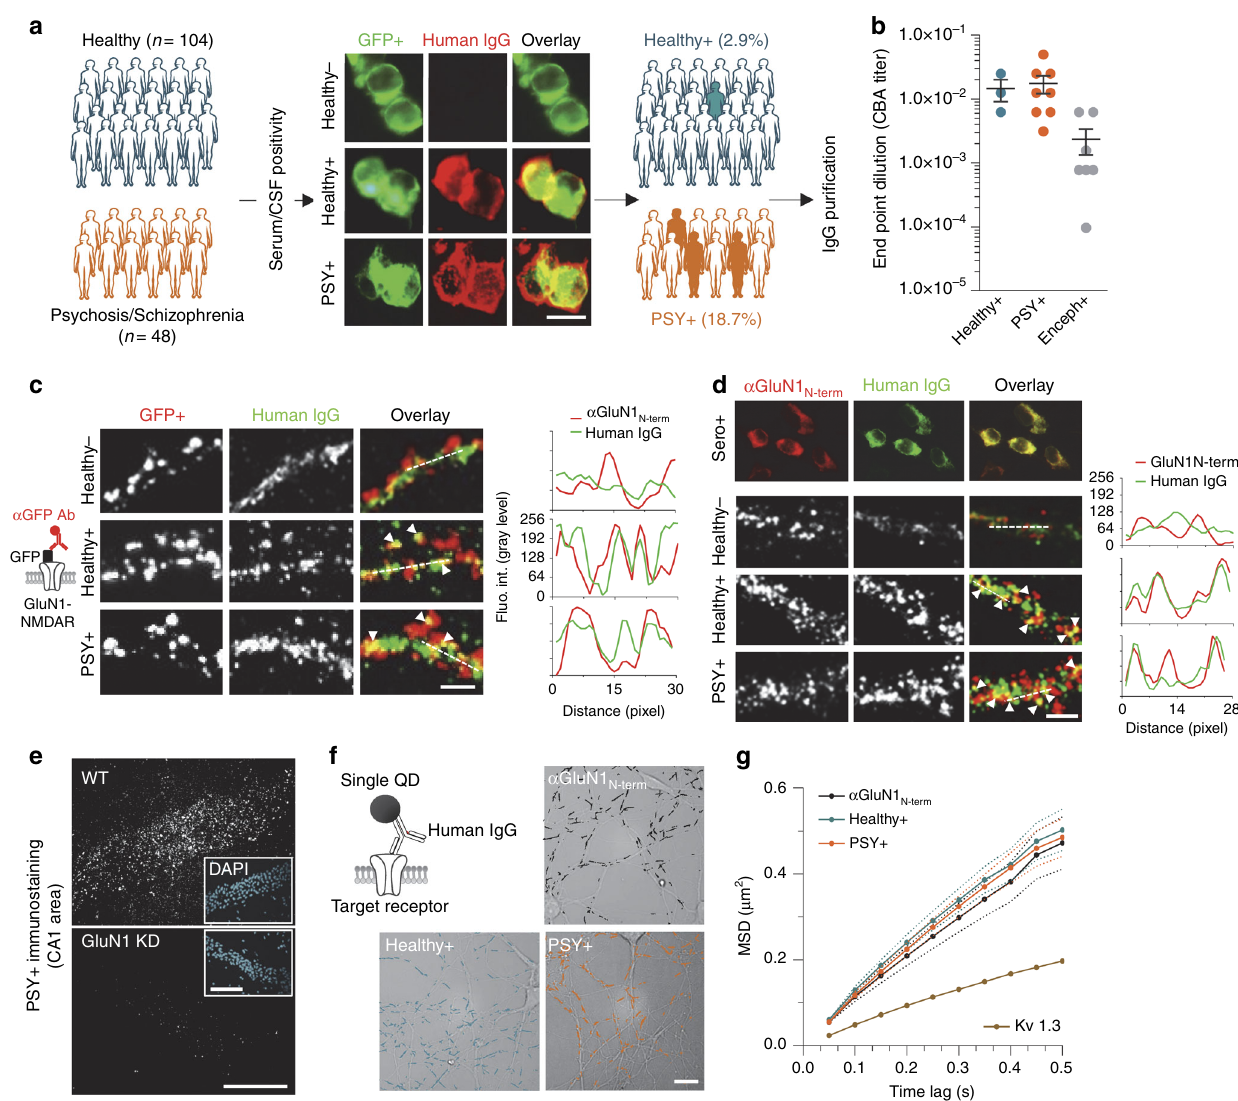
Fig. 1 Multi-approach identi fi cation of NMDAR-Ab IgG in the serum of schizophrenia patients and healthy subjects. a Immunostaining of HEK293 cells expressing GluN1-GFP and GluN2B subunits labeled with the sera of healthy subjects or schizophrenic patients (1/10, 3 h incubation). Note the overlap between serum reactivity (red) and GFP-positive HEK cells (green) for seropositive samples. Scale bar, 10 µ m. b Mean ± SEM of NMDAR-Ab titers estimated by end-point dilutions for Healthy + ( n = 3 samples), PSY + ( n = 8) and Enceph + ( n = 7) serum samples. Each data point represents the value calculated for a subject or a patient. c Surface co-immunostaining for GluN1-SEP containing NMDAR (red) and human puri fi ed IgG ’ s target (green) in live hippocampal neurons. Both Healthy + and PSY + IgG detect a target that colocalizes with surface GluN1-SEP clusters (white arrowheads). Scale bar, 2 µ m. Right panel: corresponding linescans plotting GFP + and human IgG fl uorescence intensities over distance (pixel). d Upper panel: surface co- immunostaining of HEK293 cells with a commercial anti-GluN1 antibody targeting the extracellular part of the GluN1 subunit and seropositive samples. Lower panel: representative dendritic areas of cultured hippocampal neurons (12 div) co-labeled with puri fi ed IgG (5 µ g ml − 1 , green) from Healthy − , Healthy +, or PSY + subjects and a commercial anti-GluN1 antibody targeting the extracellular part of the GluN1 subunit ( α GluN1 N-term , red). Scale bar, 2 µ m. Right panel: corresponding linescans plotting endogenous GluN1-NMDAR and human IgG fl uorescence intensities over distance (pixel). e Immunostaining of CA1 hippocampal sections (20 µ m thick) with PSY + IgG from wild-type (WT) and GluN1 knock-down (GluN1-KD) mice. Insets, DAPI staining (blue). Scale bar, 200 µ m; scale bar inset, 100 µ m. f Representative trajectories obtained with α GluN1 N-term (black lines), Healthy + (blue) and PSY + (orange) IgG-QD complexes used to label the surface target of patients ’ IgG. IgG-QD complexes were tracked during 500 frames with a 50ms acquisition frequency on cultured hippocampal neurons (14 – 15 div). Scale bar, 20 µ m. g Mean Square Displacement (MSD) over time of endogenous GluN1-NMDAR targeted by a commercial α GluN1 N-term antibody ( n = 5 neurons) or using puri fi ed IgG from Healthy + ( n = 6) or PSY + ( n = 10) individuals. The curves are represented as mean ± SEM (dash These assays were independently duplicated in two laboratories Table 1). Autoantibody titers were then estimated as end-point (Lyon, France and Barcelona, Spain). Sera from nine PSY + dilutions, ranging between 1/20 and 1/320 with no signi fi cant patients and three healthy individuals (Healthy + ) stained green difference between PSY + patients and Healthy + subjects fl uorescent protein (GFP)-positive HEK cells contrary to ser- (Fig. 1b). When these values were compared to the ones obtained onegative samples (Healthy − ) (Fig. 1a and Supplementary from gold-standard anti-NMDAR encephalitis patients, a